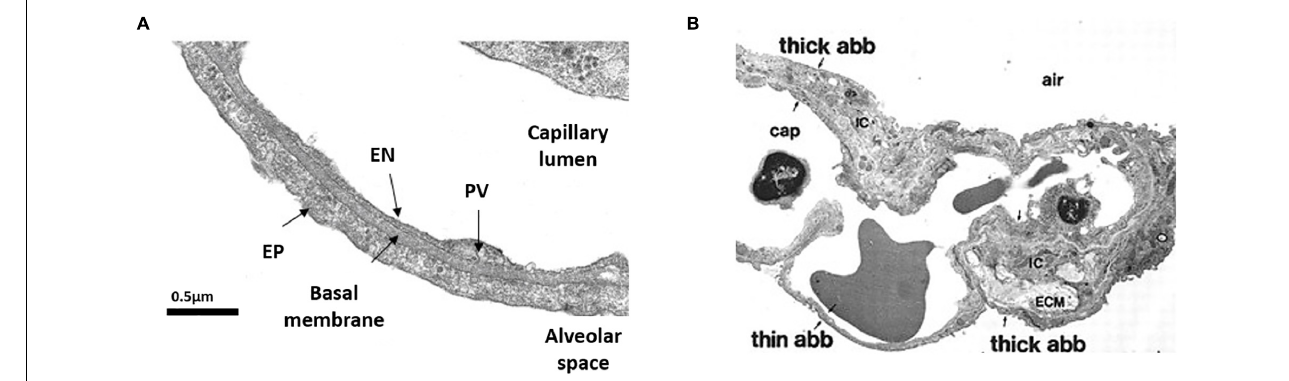
FIGURE 1 | Morphology of the air-blood barrier (ABB). (A) Thin portion of ABB showing the close apposition between alveolar epithelium (EP) and capillary endothelium (EN). PV is plasmalemmal vesicle (from Botto et al., 2006). (B) Microscopy image showing the ABB and its thin and thick portions. ECM, extra cellular matrix; cap, lung capillary; ic, interstitial cell (from Conforti et al., 2002).